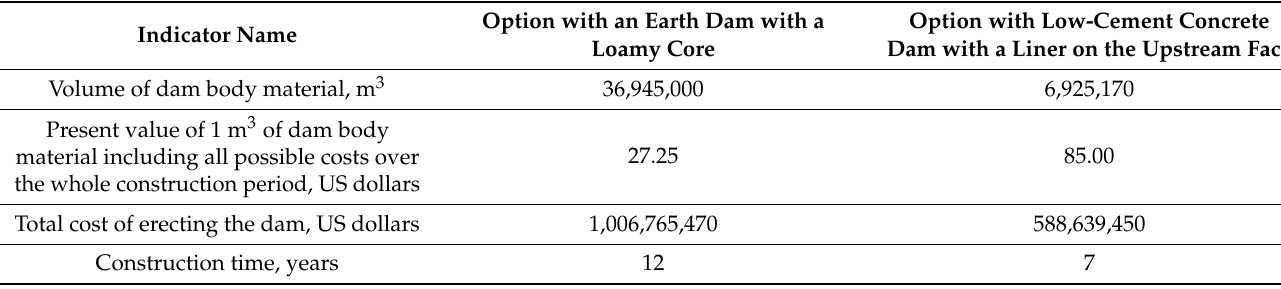
Table 3. Assessment of the cost-effectiveness of dam design